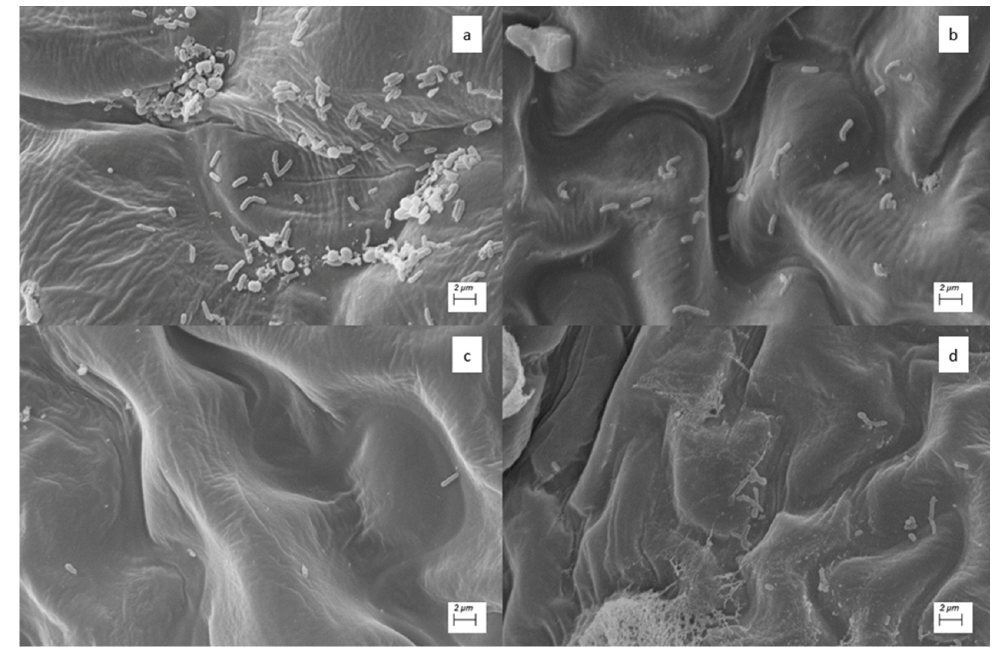
Figure 6. Electron micrograph of the ‘OhxF87 ′ rootstock after in vitro development. Acinetobacter septicus strain 23 ( a ); Acinetobacter ursingii strain 24 ( b ); A. ursingii strain 25 ( c ); A. ursingii strain 26 ( d ).